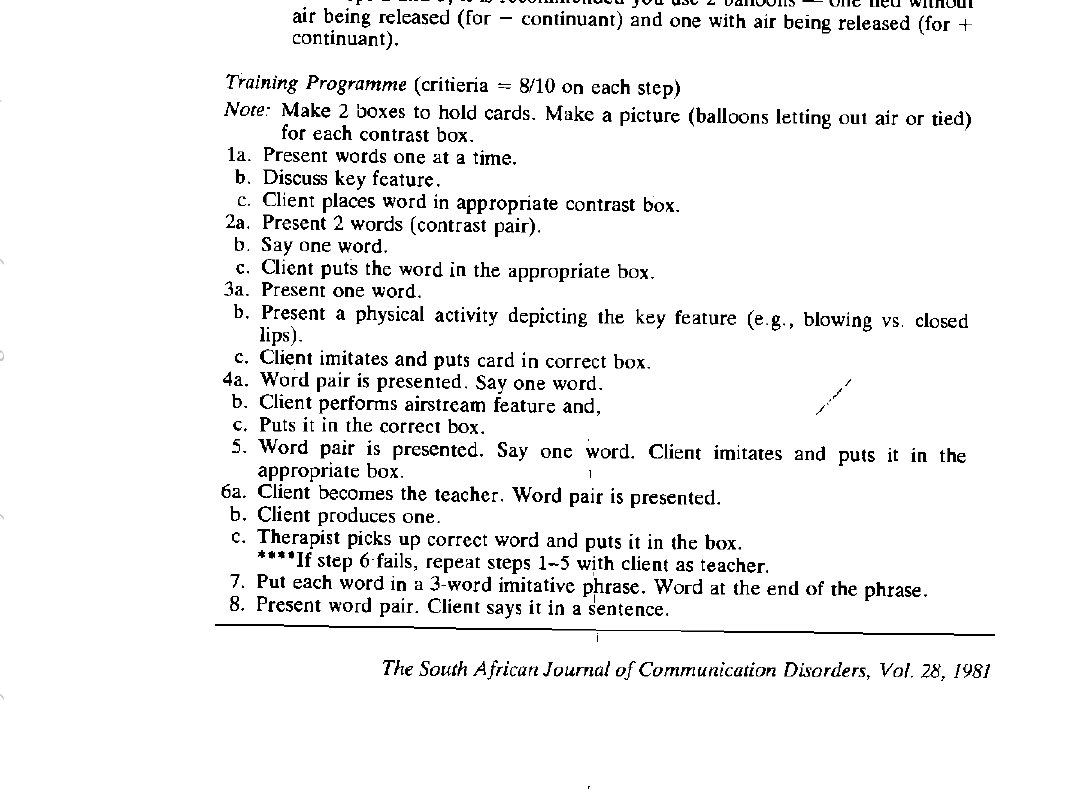
TABLE V: Phonemic Contrasting Programme for ± Continuancy Problem: Quadraplegic Spastic Cerebral Palsy Pretraining